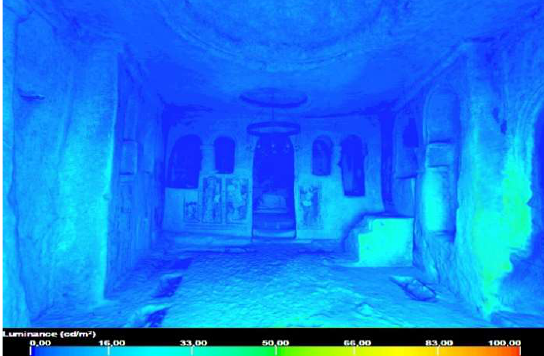
Figure 9: 3D Studio Max Sw, Lightmeter for lighting analysis.